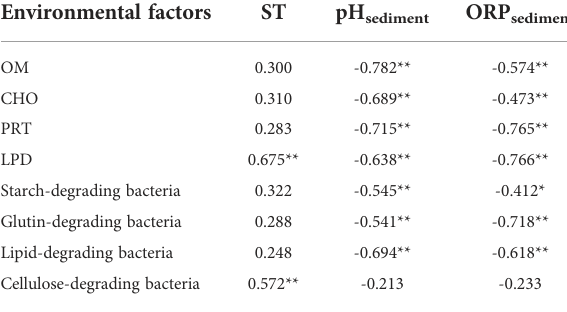
TABLE 2 Correlation analysis between environmental factors and sediment easily degradable organics and functional bacteria. Environmental